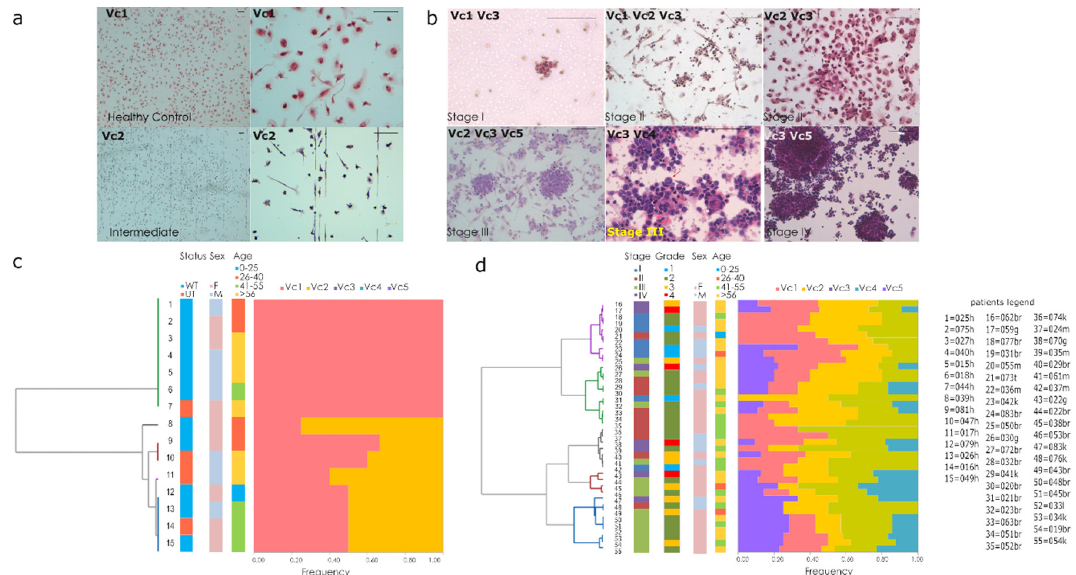
Figure 4. Cytology landscape in Blood-derived cultures ( a ) representative BDCs with lympho- monocytes elements (Vc1) and endothelial cells (Vc2) of control (Scale bars 100 µ m). ( b ) Representative BDCs of cancer patients with atypical elements (Vc3), endothelial cells (Vc2), cluster and mitotic figures (Vc4, Vc5), i.e., in stage I a thyroid tumor case; stage II breast lobular (Vc1, Vc2, Vc3) and ductal (Vc2, Vc3) cases; stage III melanoma (Vc2, Vc3, Vc5) and NSCLC (Vc3, Vc4) cases; stage IV colon adenocarcinoma (scale bars 100 µ m). ( c , d ) Hierarchical clustering based on Ward’s method for healthy ( c ) and cancer patient ( d ) each